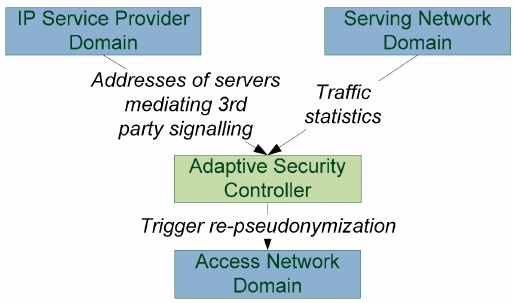
Figure 6. Domains and information in location tracking